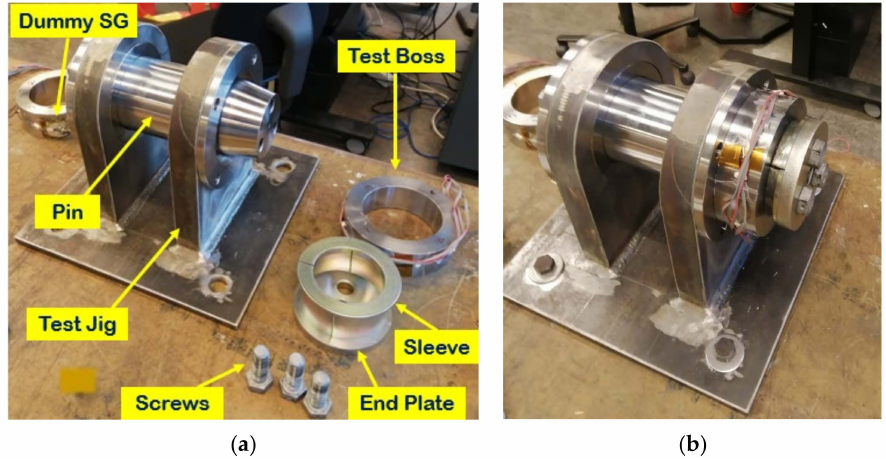
Figure 2. Experimental setup with active-dummy gauge technique. ( a ) Disassembled EPS joint components ( b ) Assembled EPS joint